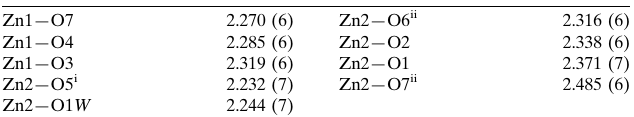
Selected bond lengths (A˚ ).